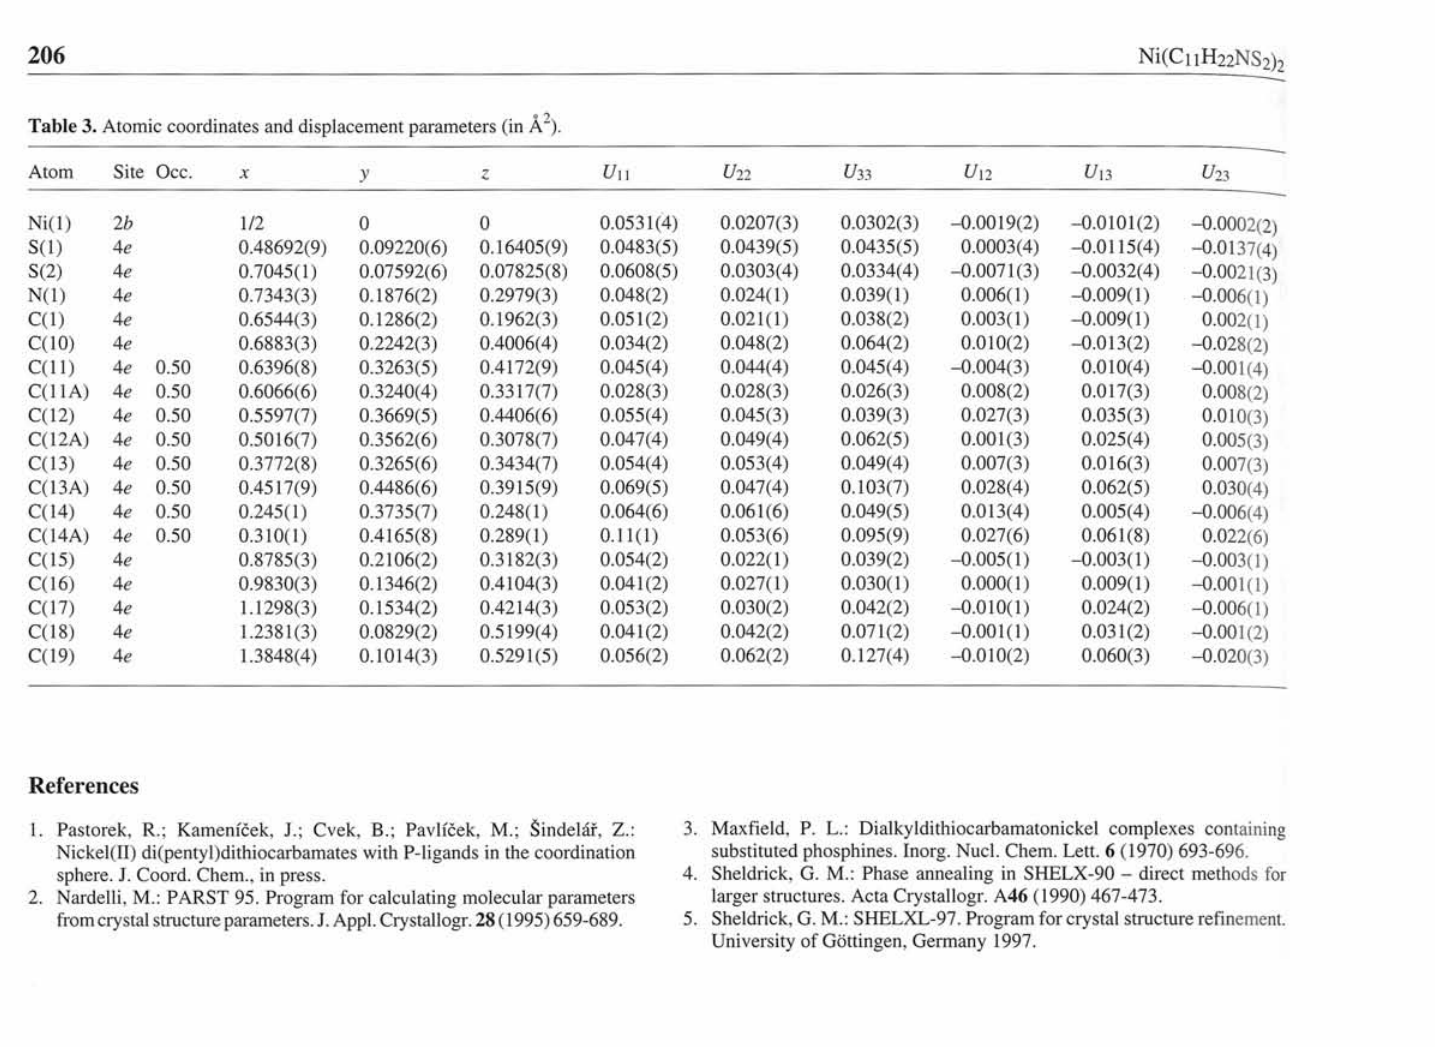
Table 3. Atomic coordinates and displacement parameters (in Á 2 ). Atom Site